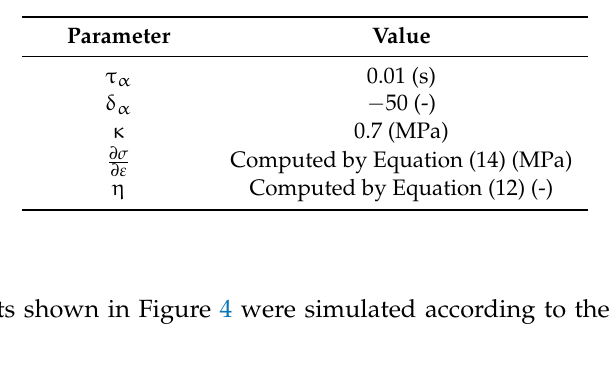
Table 5. Proposed model parameter values fitted from experimental